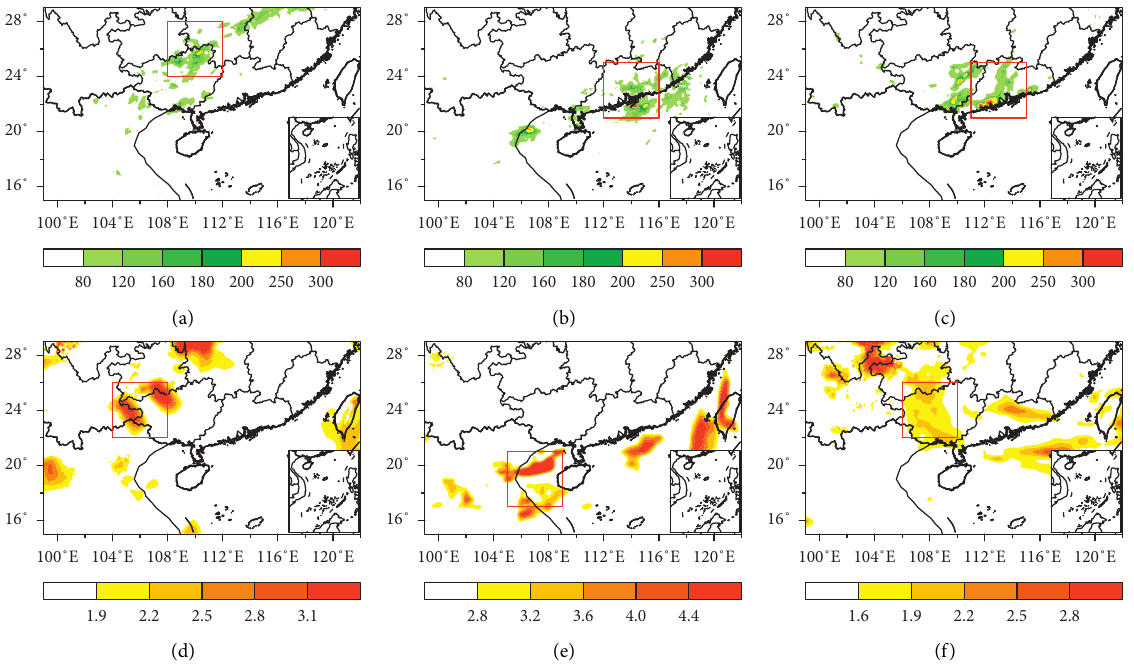
Figure 3: ((a)–(c)) Distribution of cumulative precipitation (unit: mm) in cases 1, 5, and 14, respectively (the red box is the range of the precipitation area selected). ((d)–(f)) The sensitive areas selected with the moist energy (unit: 1 × 10 5 J) method for cases 1, 5, and 14, respectively (the red box is the range of the sensitive area